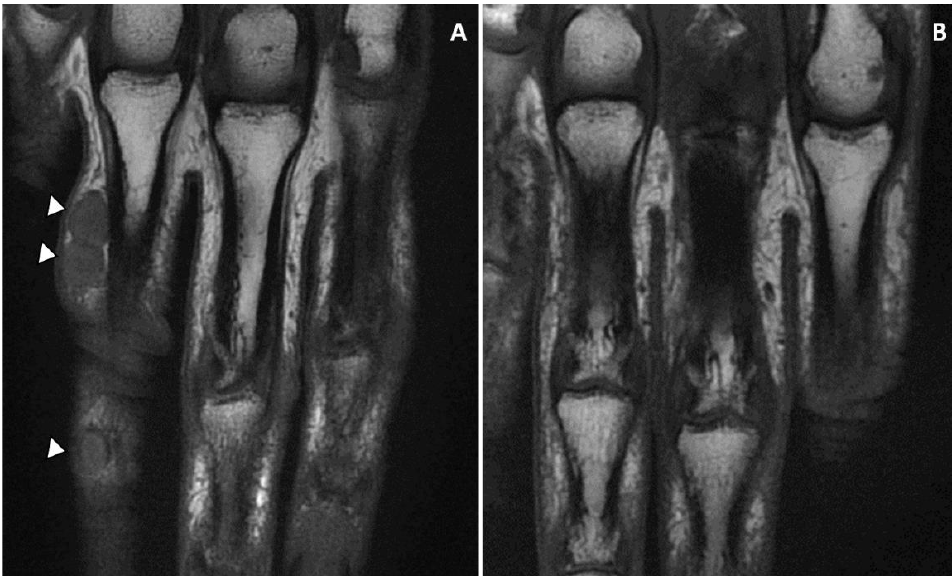
Figure 4. ( A ) The nodules on the first (bi-lobed) and the second phalanx of the fourth finger (right hand) were revealed by MRI imaging. The lesions were limited to the subcutaneous tissue with no tendon and bone involvement. ( B ) MRI imaging confirmed the complete remission at six months follow-up.